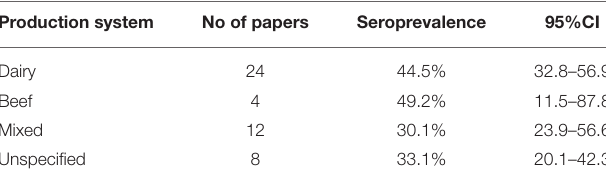
Production system